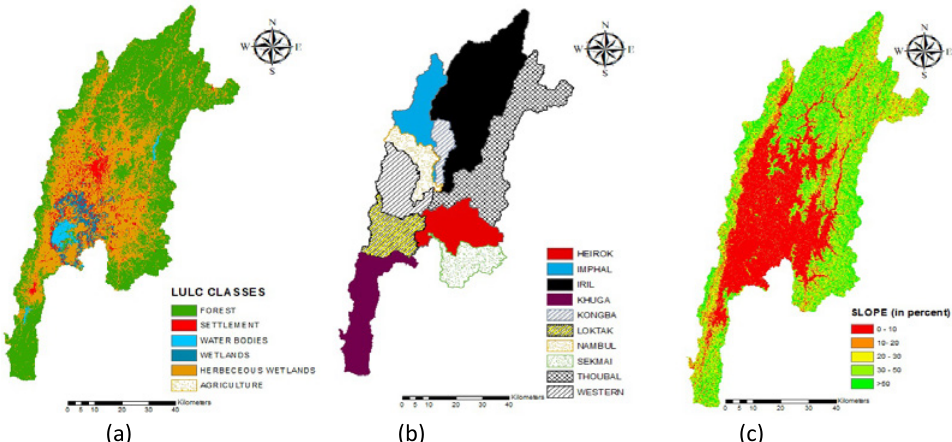
Fig. 2 (a): Land use/ land cover map, (b): Sub-basin map and (c): Slope map of Manipur river basin